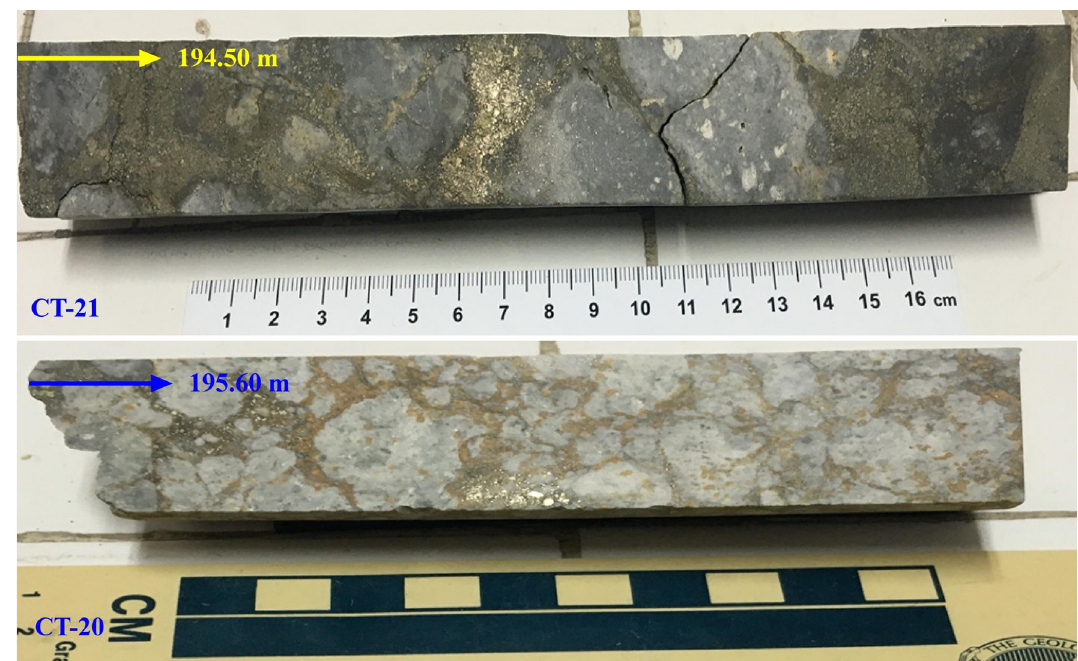
Figure 9. Close-up view of polished well log samples from Cerattepe VMSD, Drill core # CTD-117 at 1645 m.